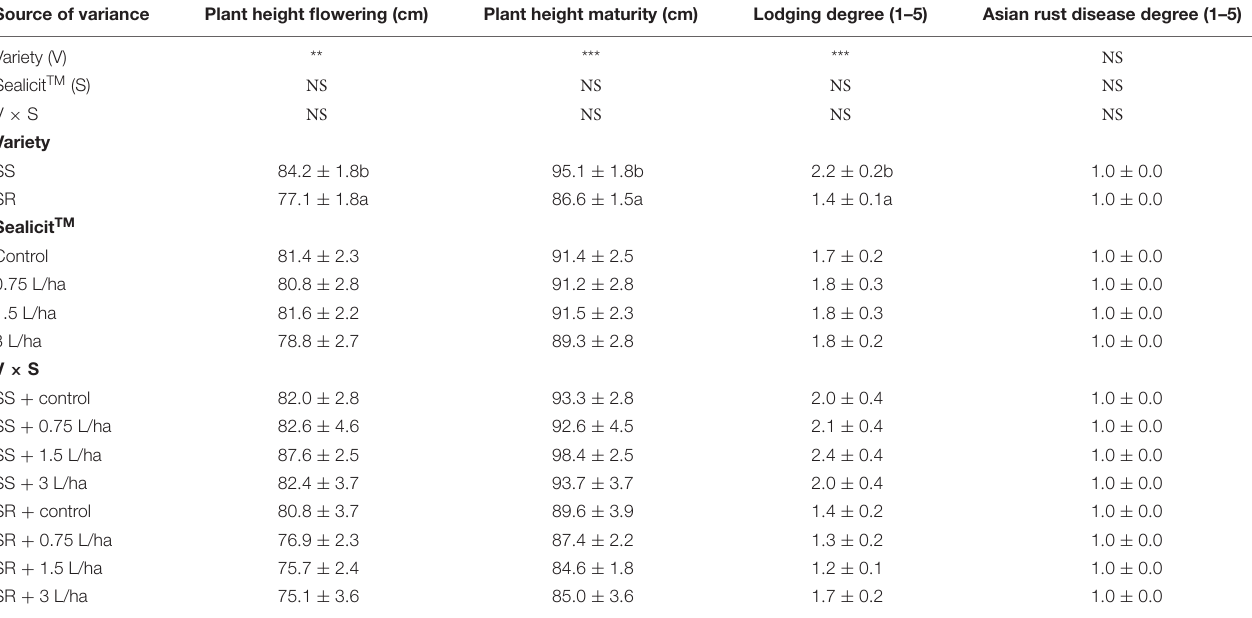
TABLE 2 | Analysis of variance and mean comparisons for plant height at flowering (R1) and full maturity (R8) stage, lodging degree, and degree of Asian rust disease with two commercial soybean varieties, treated with water and three concentrations of Sealicit TM . Source of variance